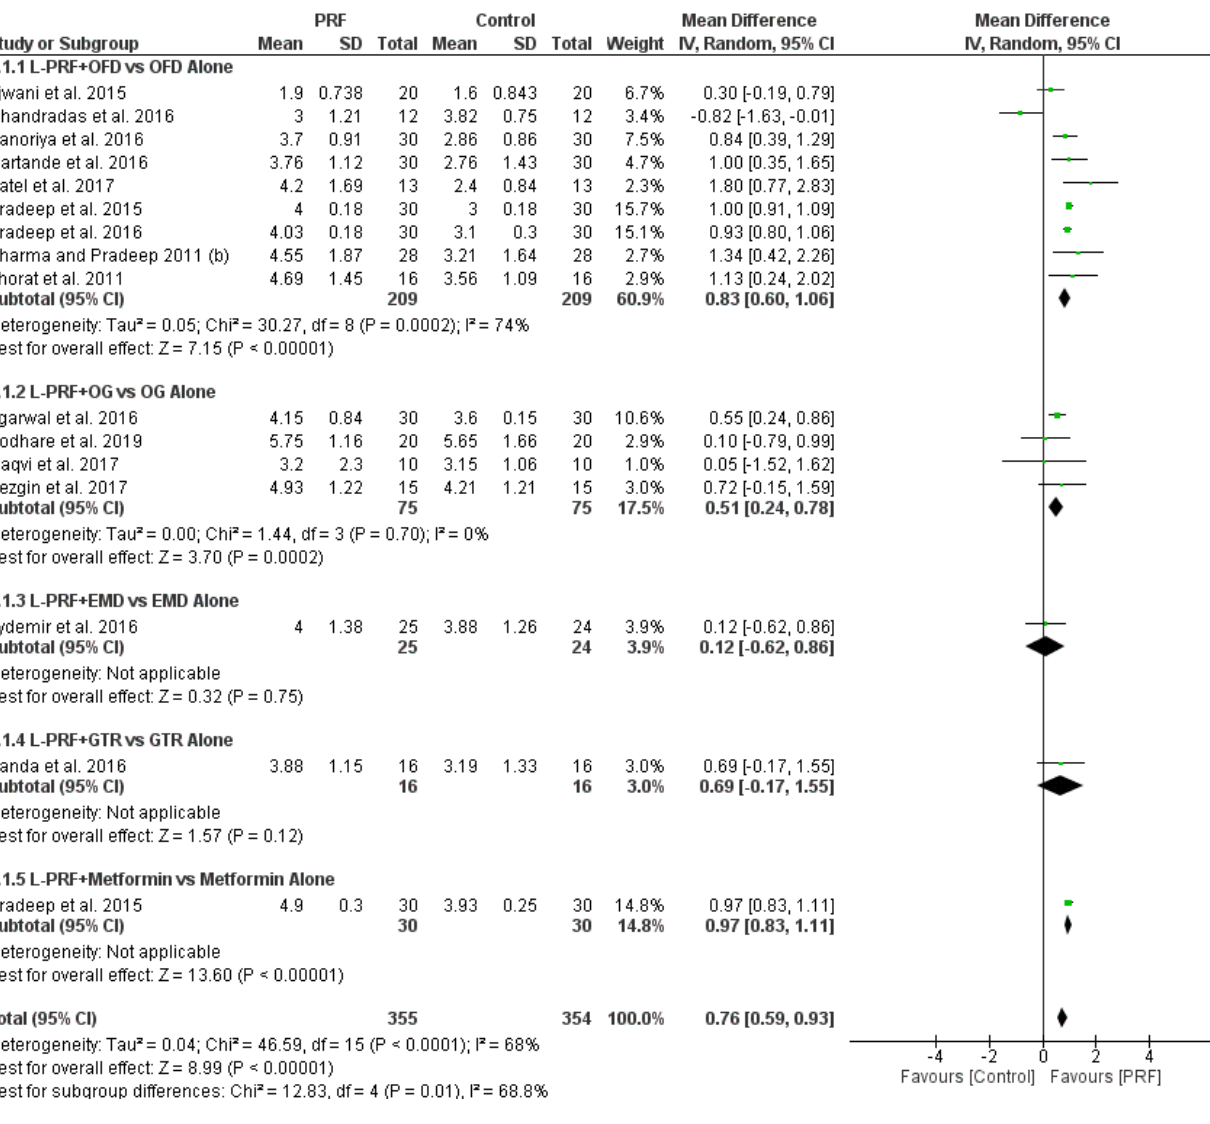
Figure 5. Forest plot of comparison. 1. Endosseous defects, outcome; 1.1. Probing pocket depth